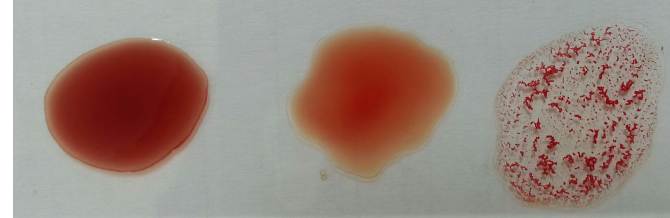
Figure 1. Blood typing